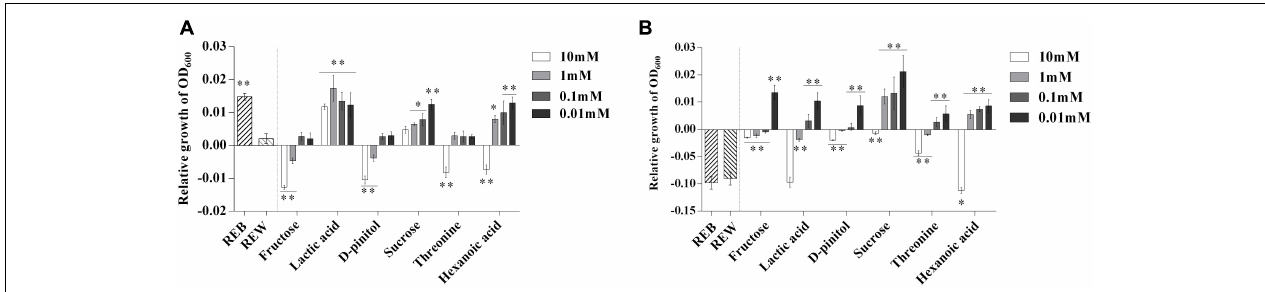
FIGURE 4 | Relative growth increment of Bacillus cereus AR156 (A) and Ralstonia solanacearum HN4 (B) in minimal medium (MM) containing tomato root exudate induced by Bacillus cereus AR156 (REB), tomato root exudate induced by water (REW) or different components from tomato root exudates induced by B. cereus AR156 at final concentrations of 0.01, 0.1, 1, and 10 mM. The mean and standard error values of three biological replicates are reported for each treatment. Asterisks in (A,B) indicate significance difference between data of treatments and data of tomato root exudate induced by sterile water (REW) within each experiment as determined by the Student’s t -test ( ∗ P < 0.05, ∗∗ P < 0.01). The experiment was carried out three times and one representative experiment is reported.